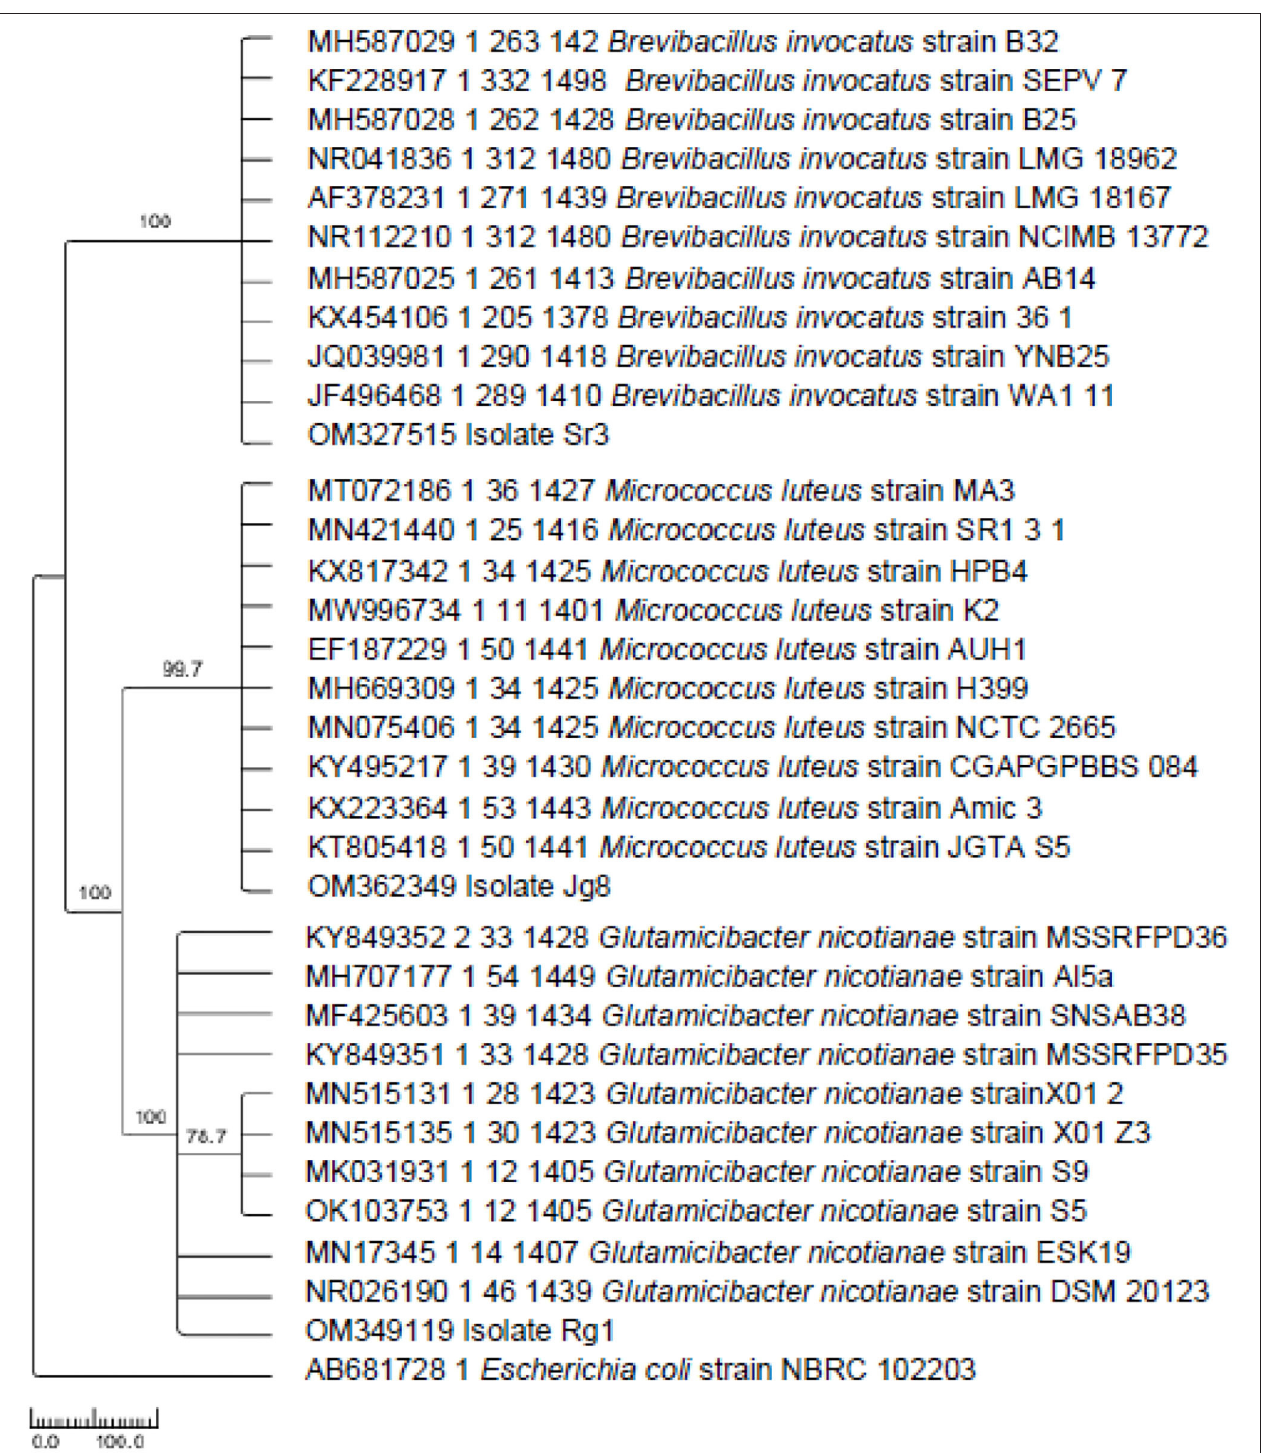
FIGURE 3 | Phylogenetic relationship tree of isolate Rg1, Sr3, and Jg8 with several isolates of bacteria based on 16S rRNA gene using maximum parsimony method.